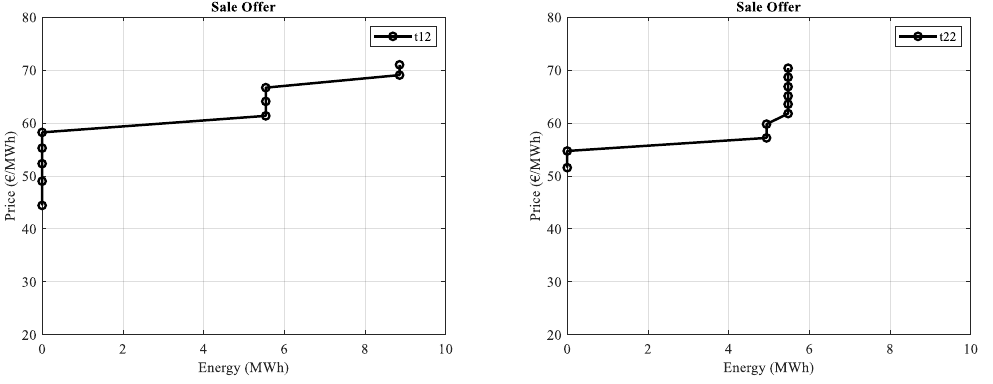
Figure 4. Purchase offering curves: left , hour 6; right , hour 11.